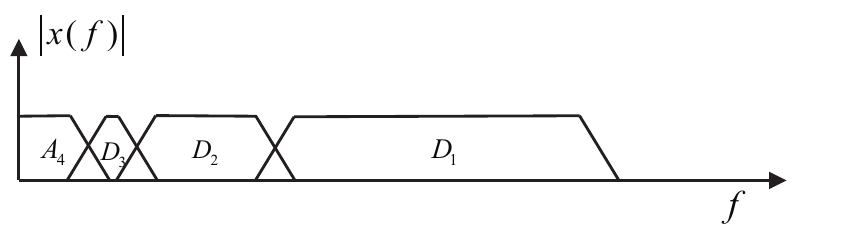
Figure 8. Band frequency distribution after applying four levels of